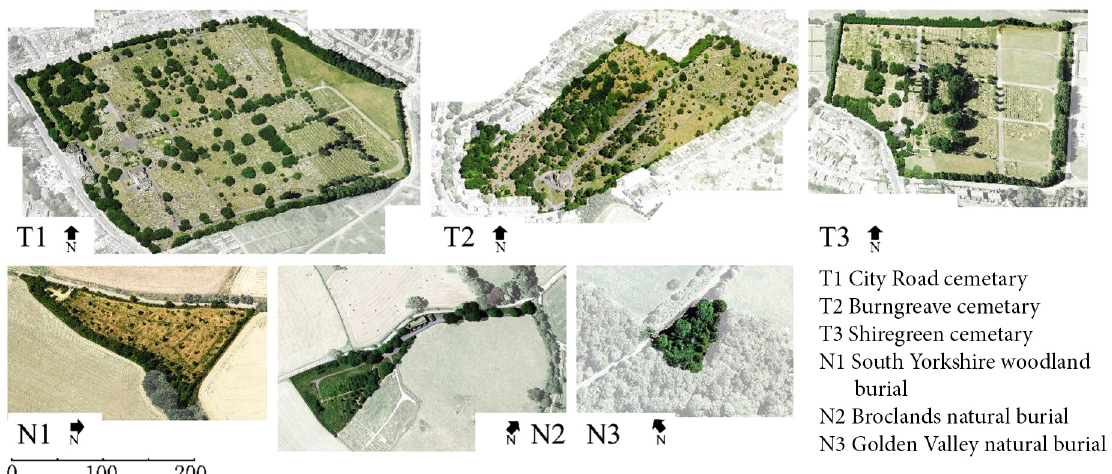
Figure 2. Aerial view of the study sites (adapted from Google Map,